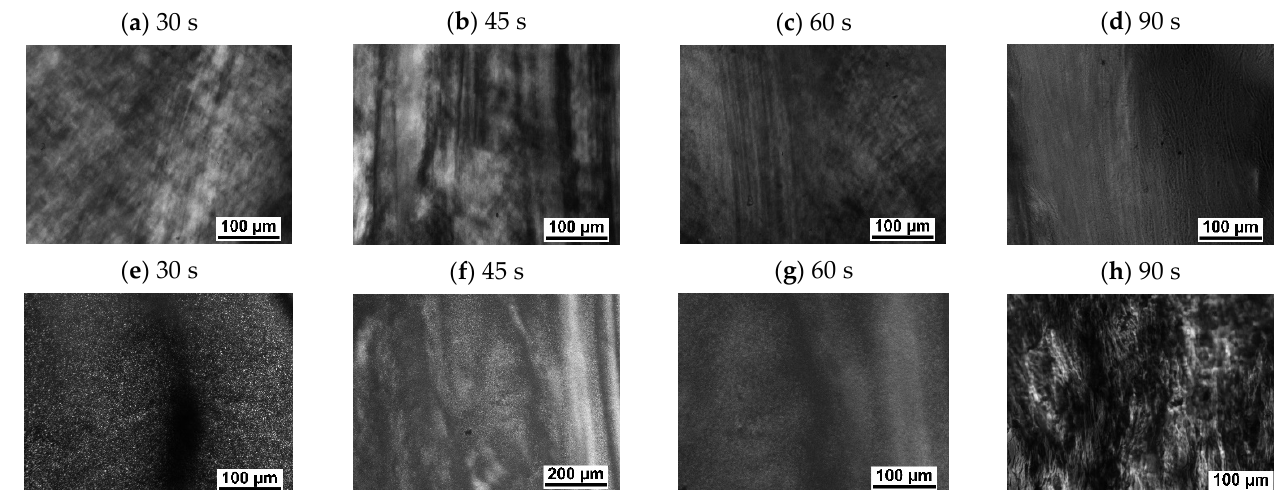
Figure 5. Effect of shearing time on chain orientation of ( a – d ) PBASGT and ( e – h ) PBAT samples, sheared before crystallization for 45 s at the cooling rate of 20 °C/min.